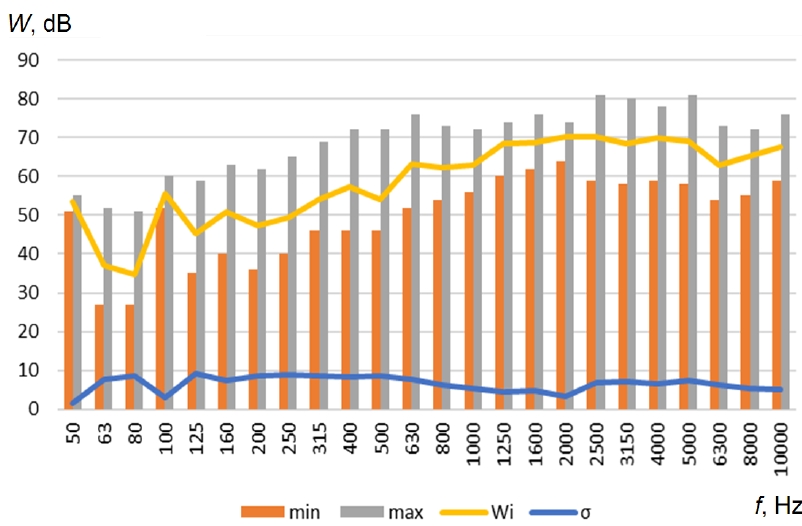
Figure 2. Primary processing of the results of EM ANU 92-2 vibrational characteristics spectrograms